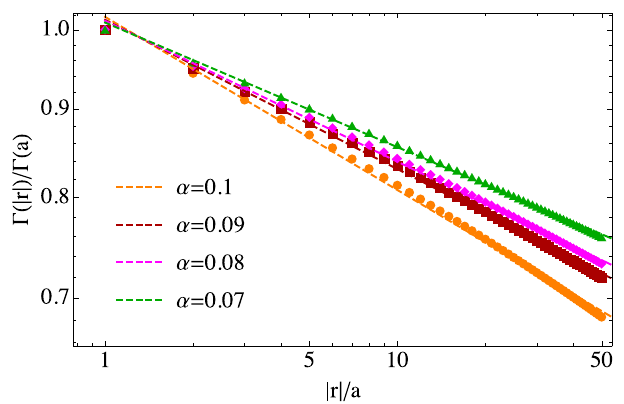
Fig. 4 Normalized long-range spin-exchange Γ ( ∣ r ∣ ) as a function of the distance between sites ∣ r ∣ . The cavity fundamental wavelength is λ = 2 π c / ω = 10 5 a , with a the lattice spacing. The symbols correspond to different values of the cavity detuning: Δ = 0.5 ω (orange), Δ = 0.1 ω (red), Δ = 0.05 ω (purple) and Δ = 0.01 ω (green). The dashed curves correspond to the fi tted power laws, with exponents reported in the